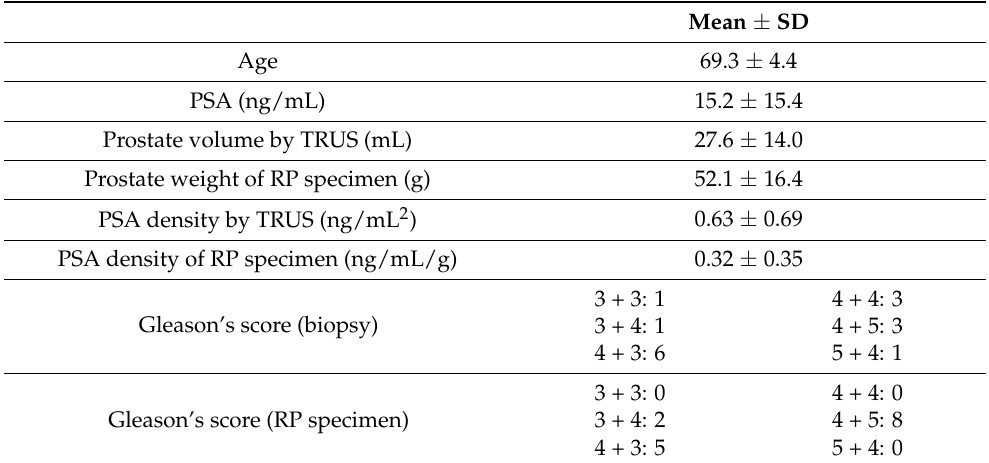
Table 1. Baseline characteristics of 15 PCa patients.